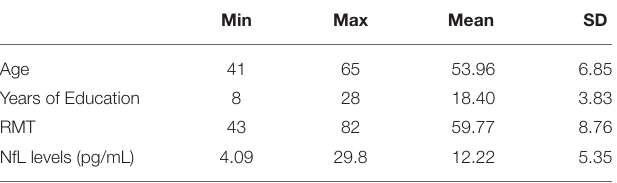
TABLE 1 | Demographic Variables, RMT and NfL plasma values ( n =